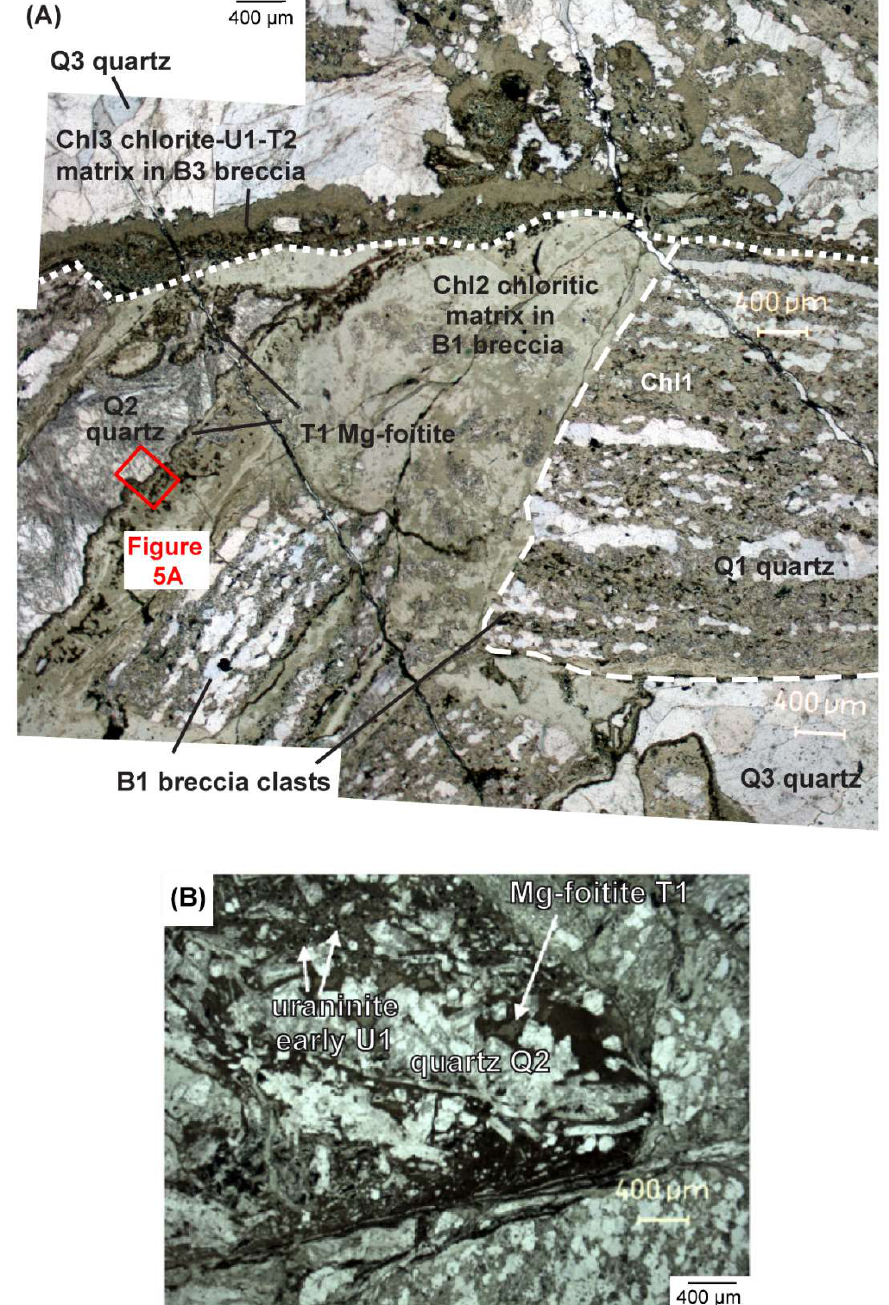
Figure 4. Chlorite-tourmaline-quartz generations and assemblages at the Ranger U deposit (Australia), from Skirrow et al. [4]. ( A ) Thin section studied for boron isotopes and major elements showing pre-ore B1 breccia, pre-ore silicification and main U1 ore stage. B1 breccia is composed of lithic clasts of banded quartz Q1 and chlorite Chl1 within a matrix of chlorite Chl2 and chlorite Chl3 that corrodes quartz. Some voids in B1 breccia are lined by tourmaline T1 and filled by quartz Q2 corresponding to the pre-ore silicification stage and B2 breccia. Both the B1 breccia and Q2-T1 assemblages were cut by ore-stage B3 breccia, with infill by chlorite Chl3, tourmaline T2, and uraninite U1. Voids in the B3 breccia matrix were filled by quartz Q3. Sample from drillhole S3PD759 402.9 m, transmitted light, from Skirrow et al. [4]. ( B ) Clast in B3 breccia containing intergrowths of euhedral quartz Q2, brownish fine-grained tourmaline T1, and fine-grained disseminated uraninite U1. Sample from drillhole S3PD759 395.3 m, transmitted light, from Skirrow et al. [4].